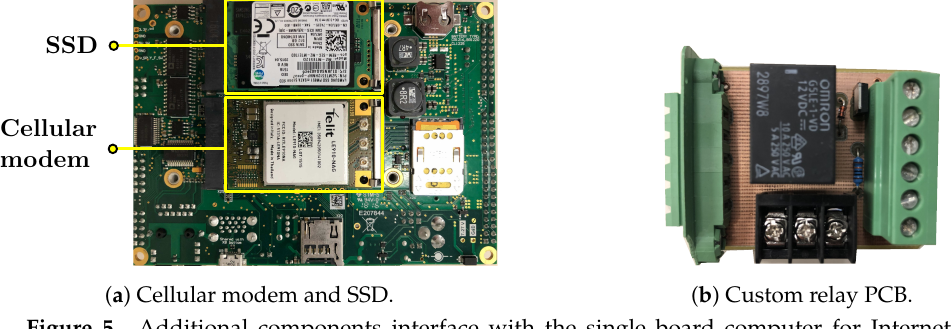
Figure 5. Additional components interface with the single board computer for Internet access, data storage, and power control